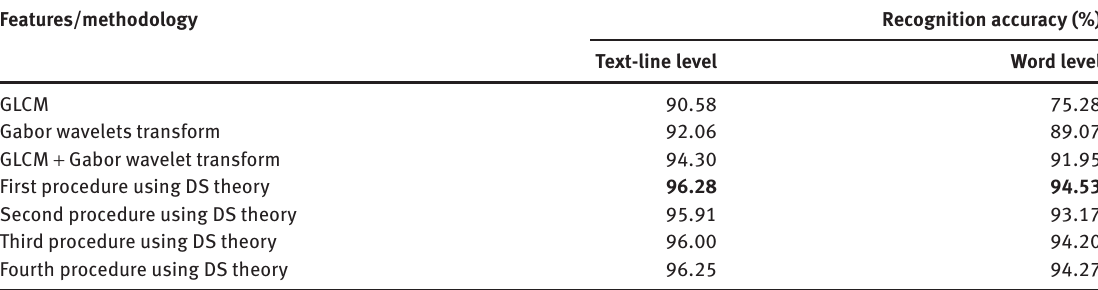
Table 5: Performance Comparison of the Present Feature Set with Their Combination at Both Text-Line and Word Levels (Bold Style Shows the Best Case).